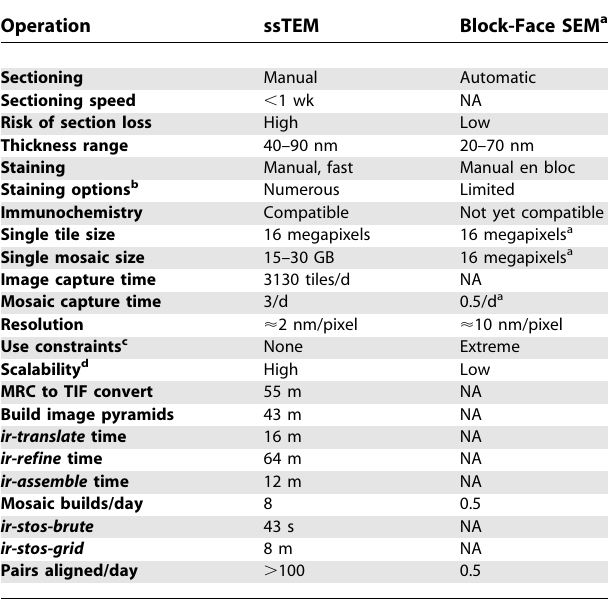
Table 2. Platform Comparisons for a 250 l m Diameter x 30 l m High Volume